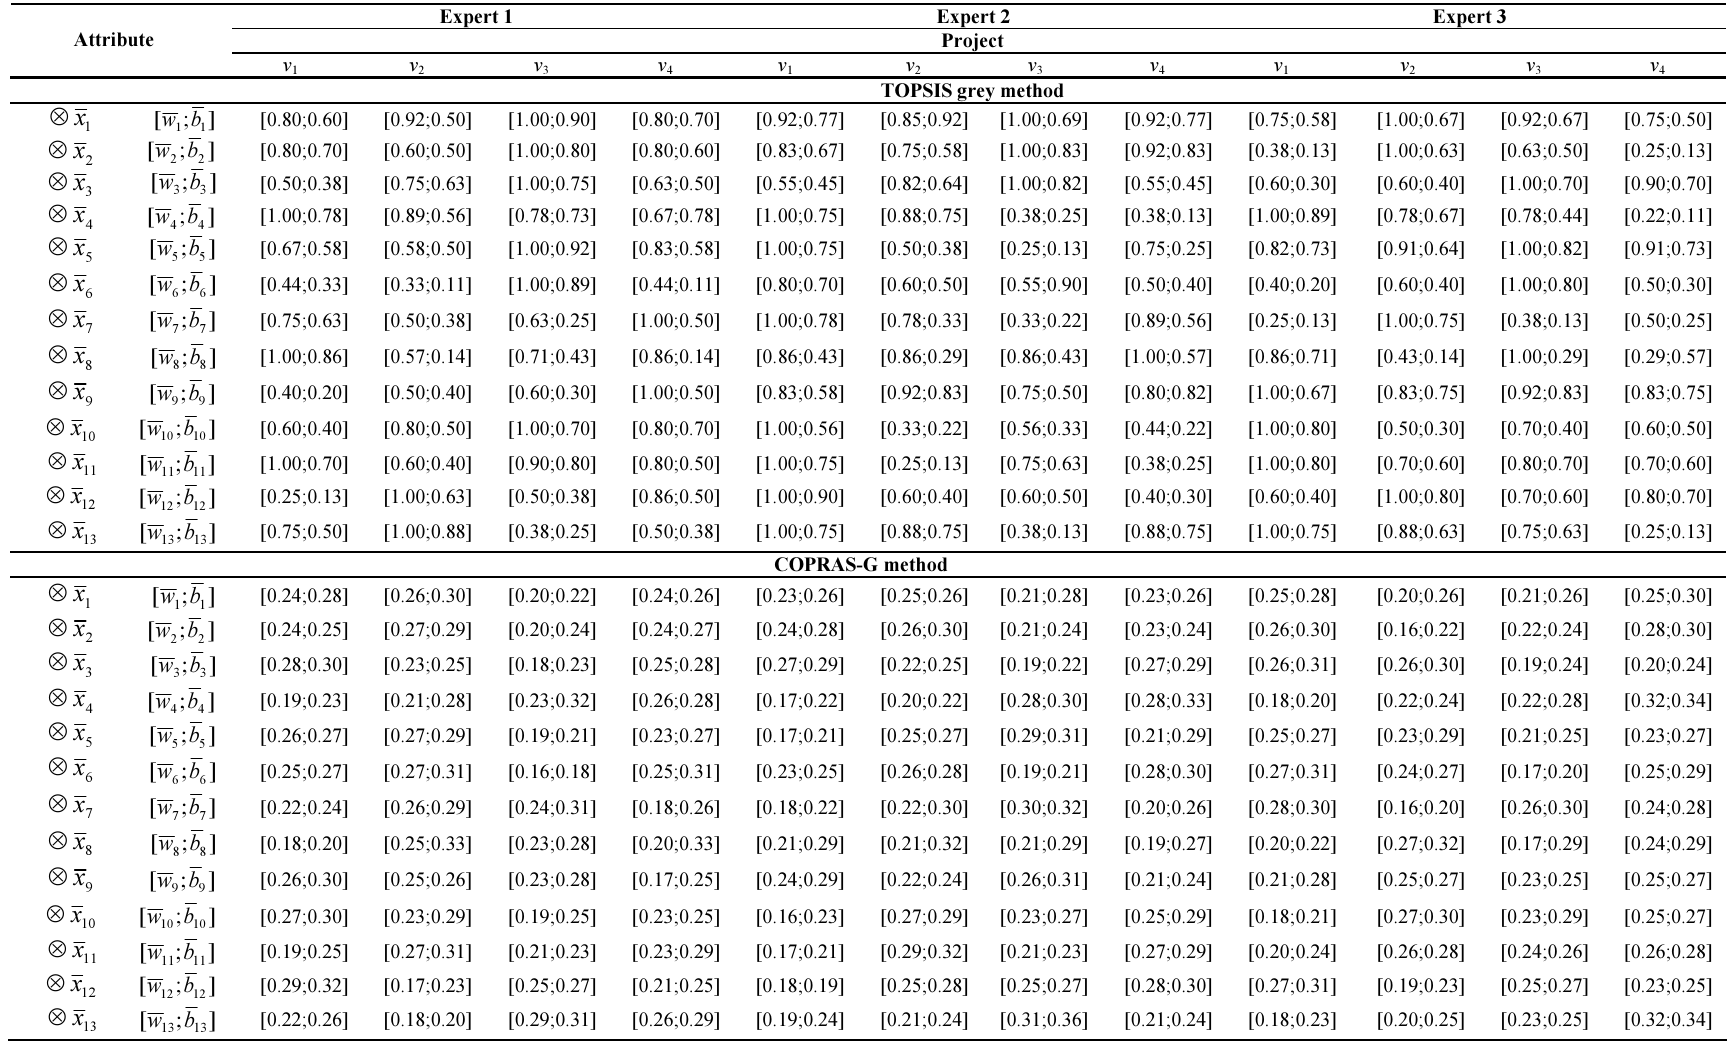
Table 2. Normalized decision-making